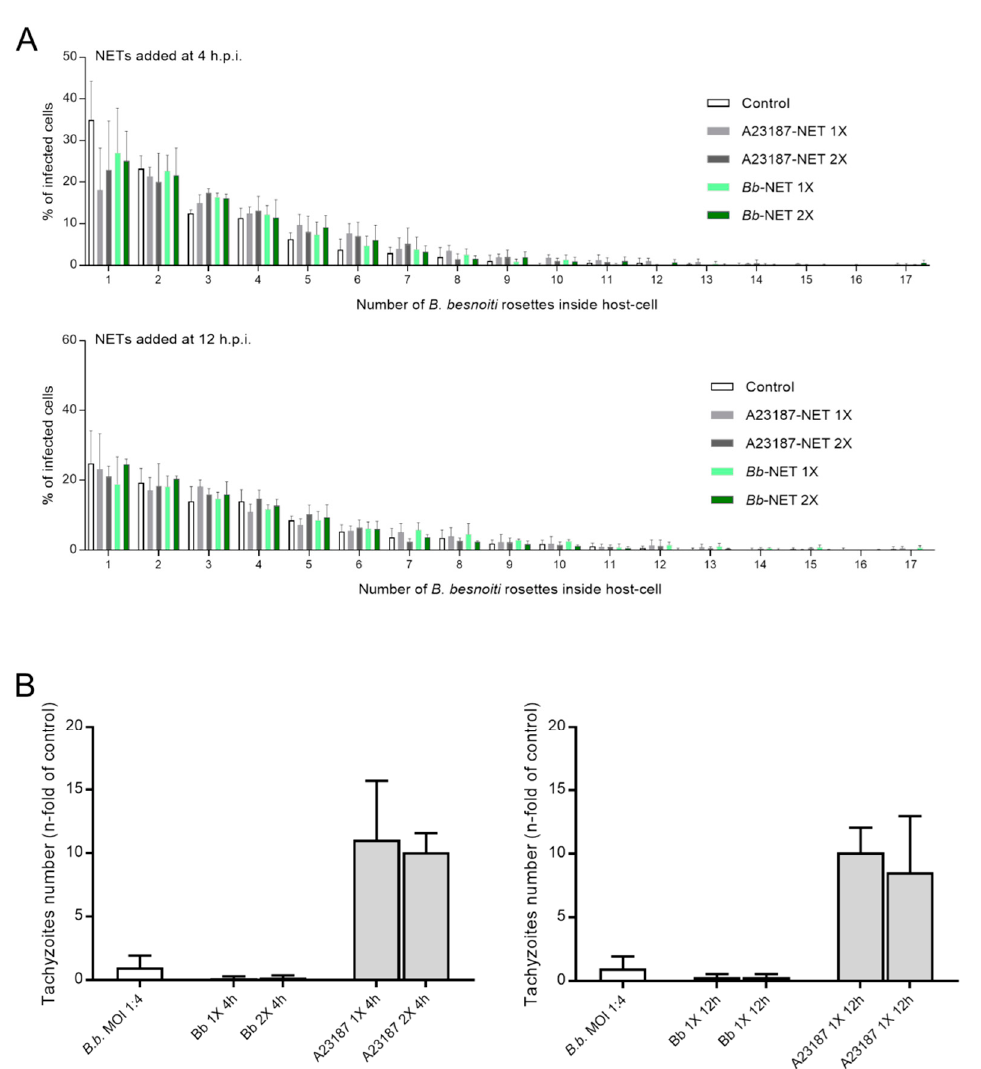
Figure 7. Effects of Bb -NET and A23187-NET treatments on intracellular B. besnoiti rosettes formation and tachyzoite release. B. besnoiti -infected BUVEC (three different isolates, N = 3), were treated with Bb -NETs or A231887-NETs at 1X and 2X concentrations at 4 and 12 h.p.i. All treatments were performed in duplicates. At 24 h.p.i. cells were analyzed by randomly taking five images for each experimental condition using phase contrast microscopy. The total number of B. besnoiti rosettes per host cell at 4 ( n = 1115) and 12 h.p.i. ( n = 970) was determined and the percentage of host cells carrying different numbers of rosettes was calculated ( A ) In addition, the total number of tachyzoites being released into cell supernatant within 30 h.p.i. was estimated via qPCR ( B ). Bars represents mean ± SD.